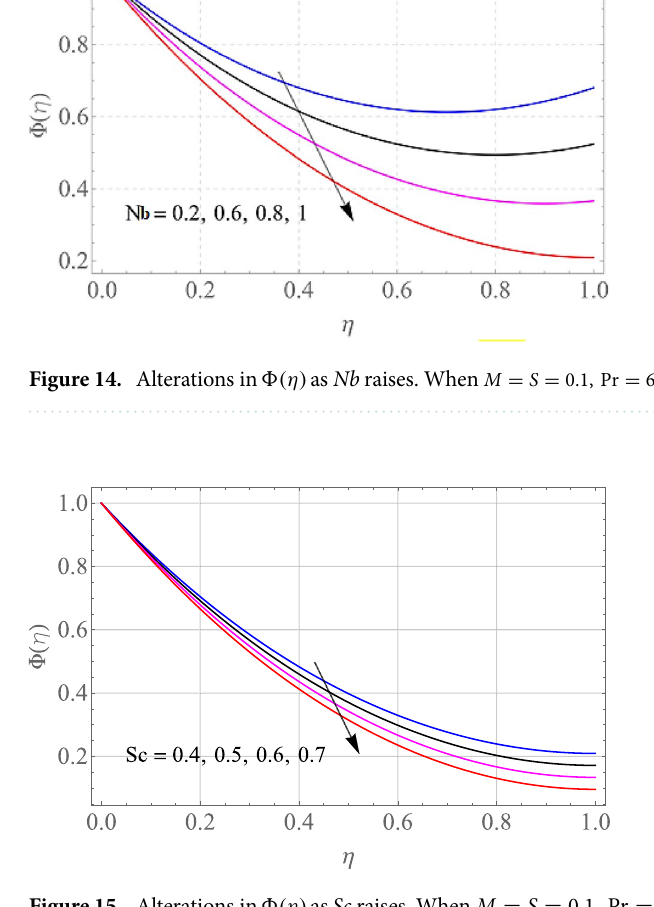
Figure 15. Alterations in �(η) as Sc raises. When M = S = 0.1, Pr = 6.2, Gc = Gr = 0.2, Ec = 1, Nb = 0.3